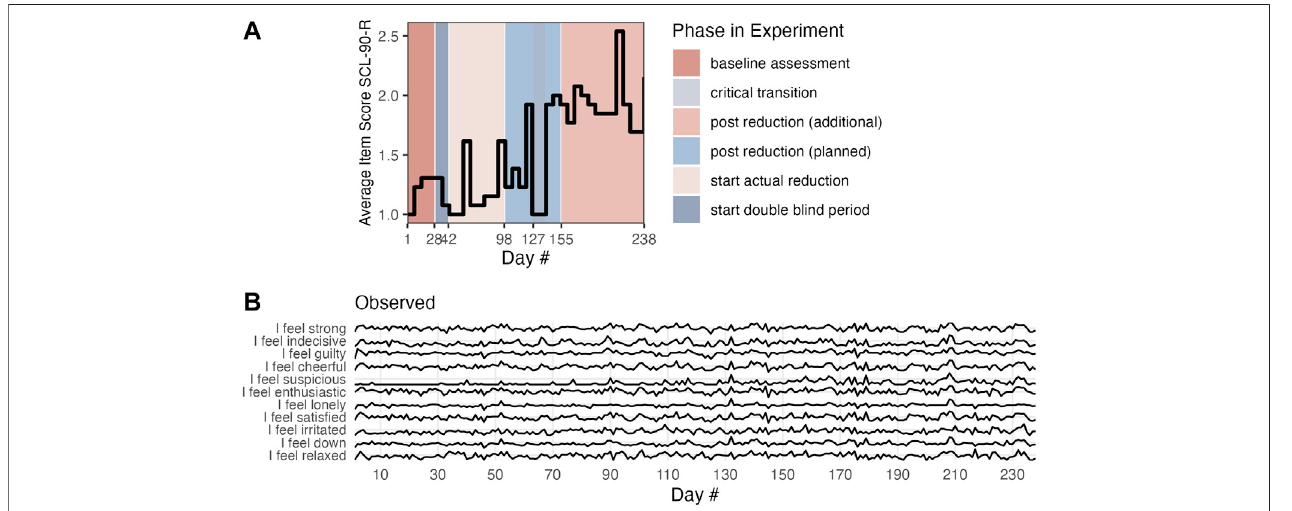
FIGURE 1 | Panel (A) shows the state variable (SCL-90-R). Panel (B) is an example of the subset of Mood time